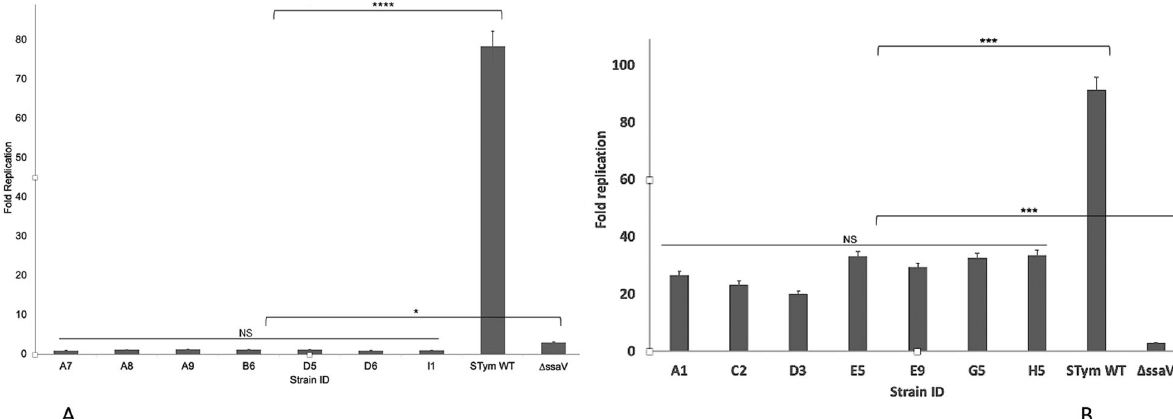
Figure 7. Intracellular replication of S . Salamae ( A ) and S. Waycross ( B ) in mouse macrophage J774 cell lines. NS: not significant; p > 0.05; * p < 0.05; *** p < 0.0001; **** p <